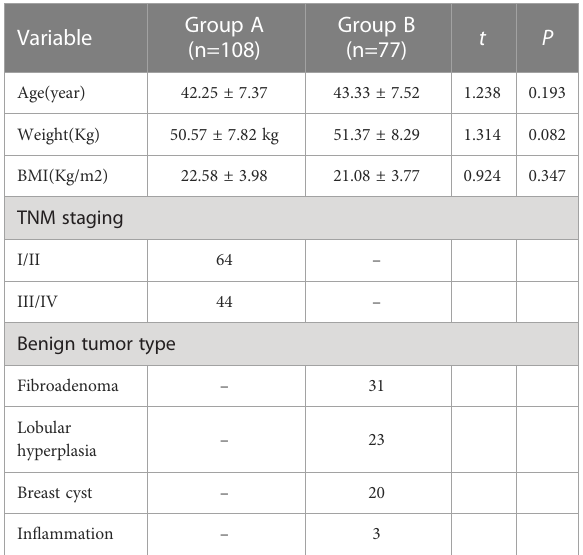
TABLE 1 The basic information of the two